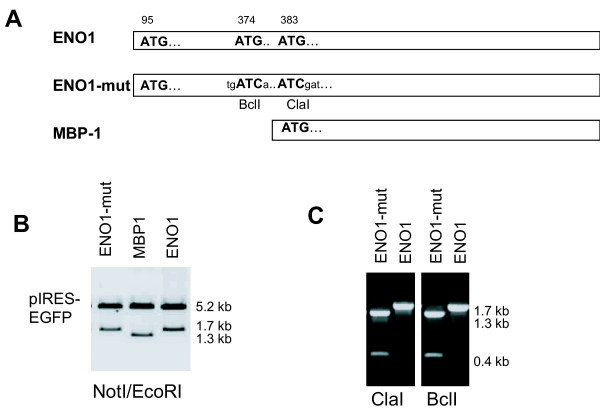
A. ENO1, ENO1-mut and MBP-1-constructs with translation starts (ATG) and mutated (ATG→ATC) sites in ENO1-mut at positions 374 and 383 indicated. The mutations introduce Bcl I and Cla I restriction enzyme sites respectively. B. Size determination of cDNA-constructs in pIRES-EGFP-vector by NotI/EcoRI-digest. C. Confirmation of mutations in ENO1-mut DNA by ClaI and BclI digests.